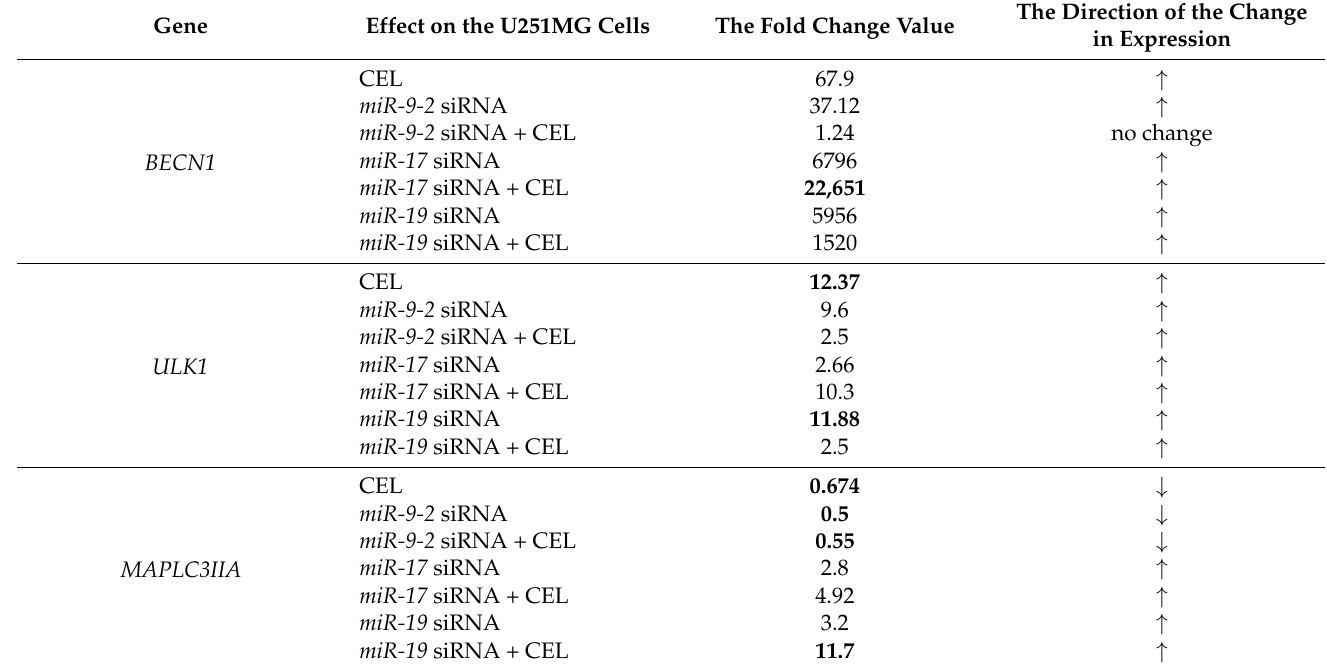
Table 7. Mean fold change value (relative to the control cells) and the direction of the change in the expression of the autophagy-related genes in the U251MG